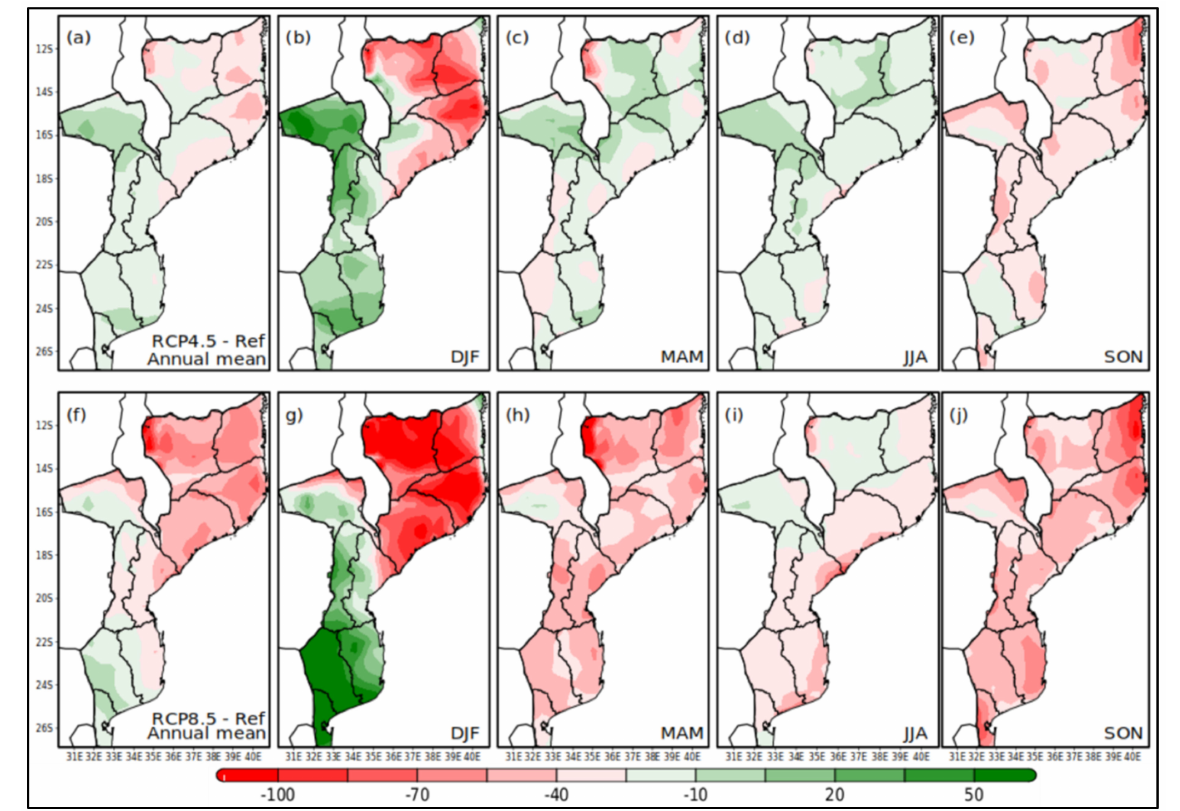
Figure 11. Signal of future climate changes in annual and seasonal mean precipitation (mm/month), under the RCP4.5 and RCP8.5 scenarios for 2070–2099 with respect to reference period (Ref, 1971–2000), simulated by RegCM4. The first column in the panel represent the difference of annual average and each of the rest of the maps match to seasonal differences (DJF, MAM, JJA, and